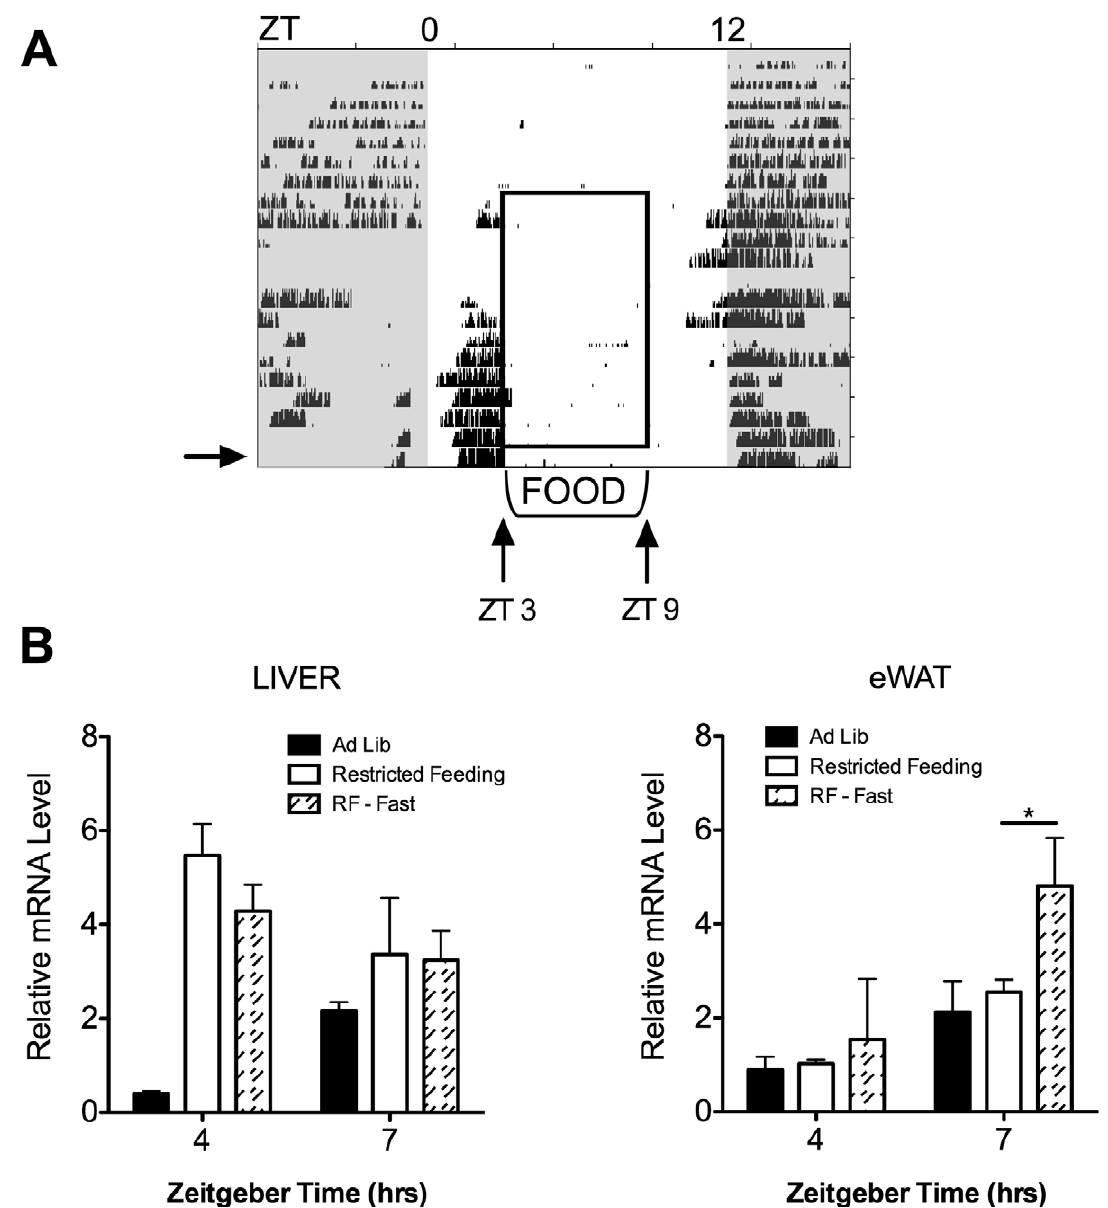
Figure 4. Nocturnin is induced by fasting in eWAT tissue of restricted fed mice. ( A ) Schematic representation of feeding paradigm and absence of meal on the thirteenth day of restricted feeding. Actogram is as described in Figure 2, and is a representative wheel running actogram of restricted fed mice. Mice were habituated to a 12:12 LD cycle for seven days, restricted feeding began on Day 8. On the 13th day of restricted feeding (indicated by the arrow), mice were not given the expected meal at ZT3, the condition labeled as RF-Fast. ( B ) Gene expression analysis of the liver (left panel) and the epididymal white adipose tissue (eWAT, right panel) reveal that Nocturnin is induced by the absence of the meal in eWAT only. The data from the ad libitum control group and from the restricted fed group (RF) are the same as from Figure 2 and has been re-graphed here for comparison. Data represent the mean of the group ( 6 SEM); for each time point, n=3 for the ad libitum group, n=6 for the restricted-fed group, and n=4 for the RF-fasted group. * = t-test, p-value